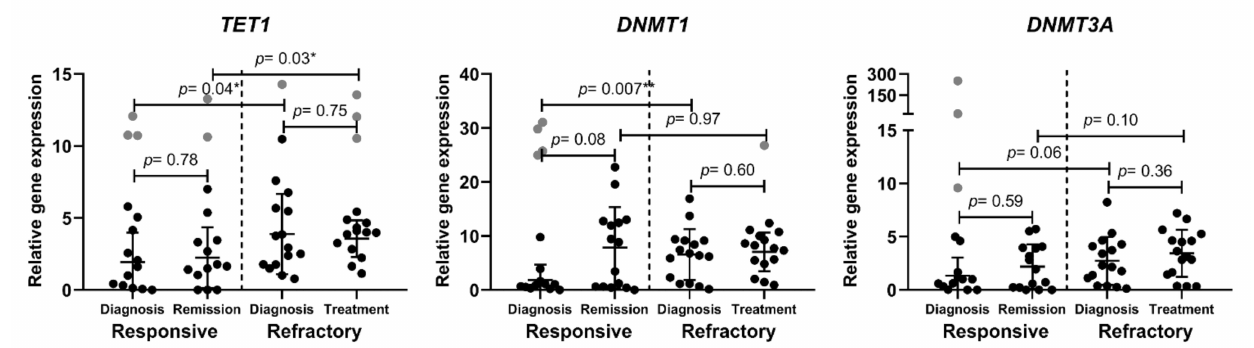
Figure 3. Epigenetic DNA modification-related gene expression analysis in treatment-responsive and -refractory AML patients. Cell samples were collected at diagnosis stage and after treatment. Relative gene expression analysis was performed the using RT-qPCR ∆∆ Ct method; GAPDH was used as a “housekeeping” gene. Mean ± standard deviation is presented; grey data points indicate outliers. Mann–Whitney U test was used to determine the significance of difference between groups of different patients’ samples, and significance was set at p ≤ 0.05 (*). Outliers were determined by ROUT (Q =